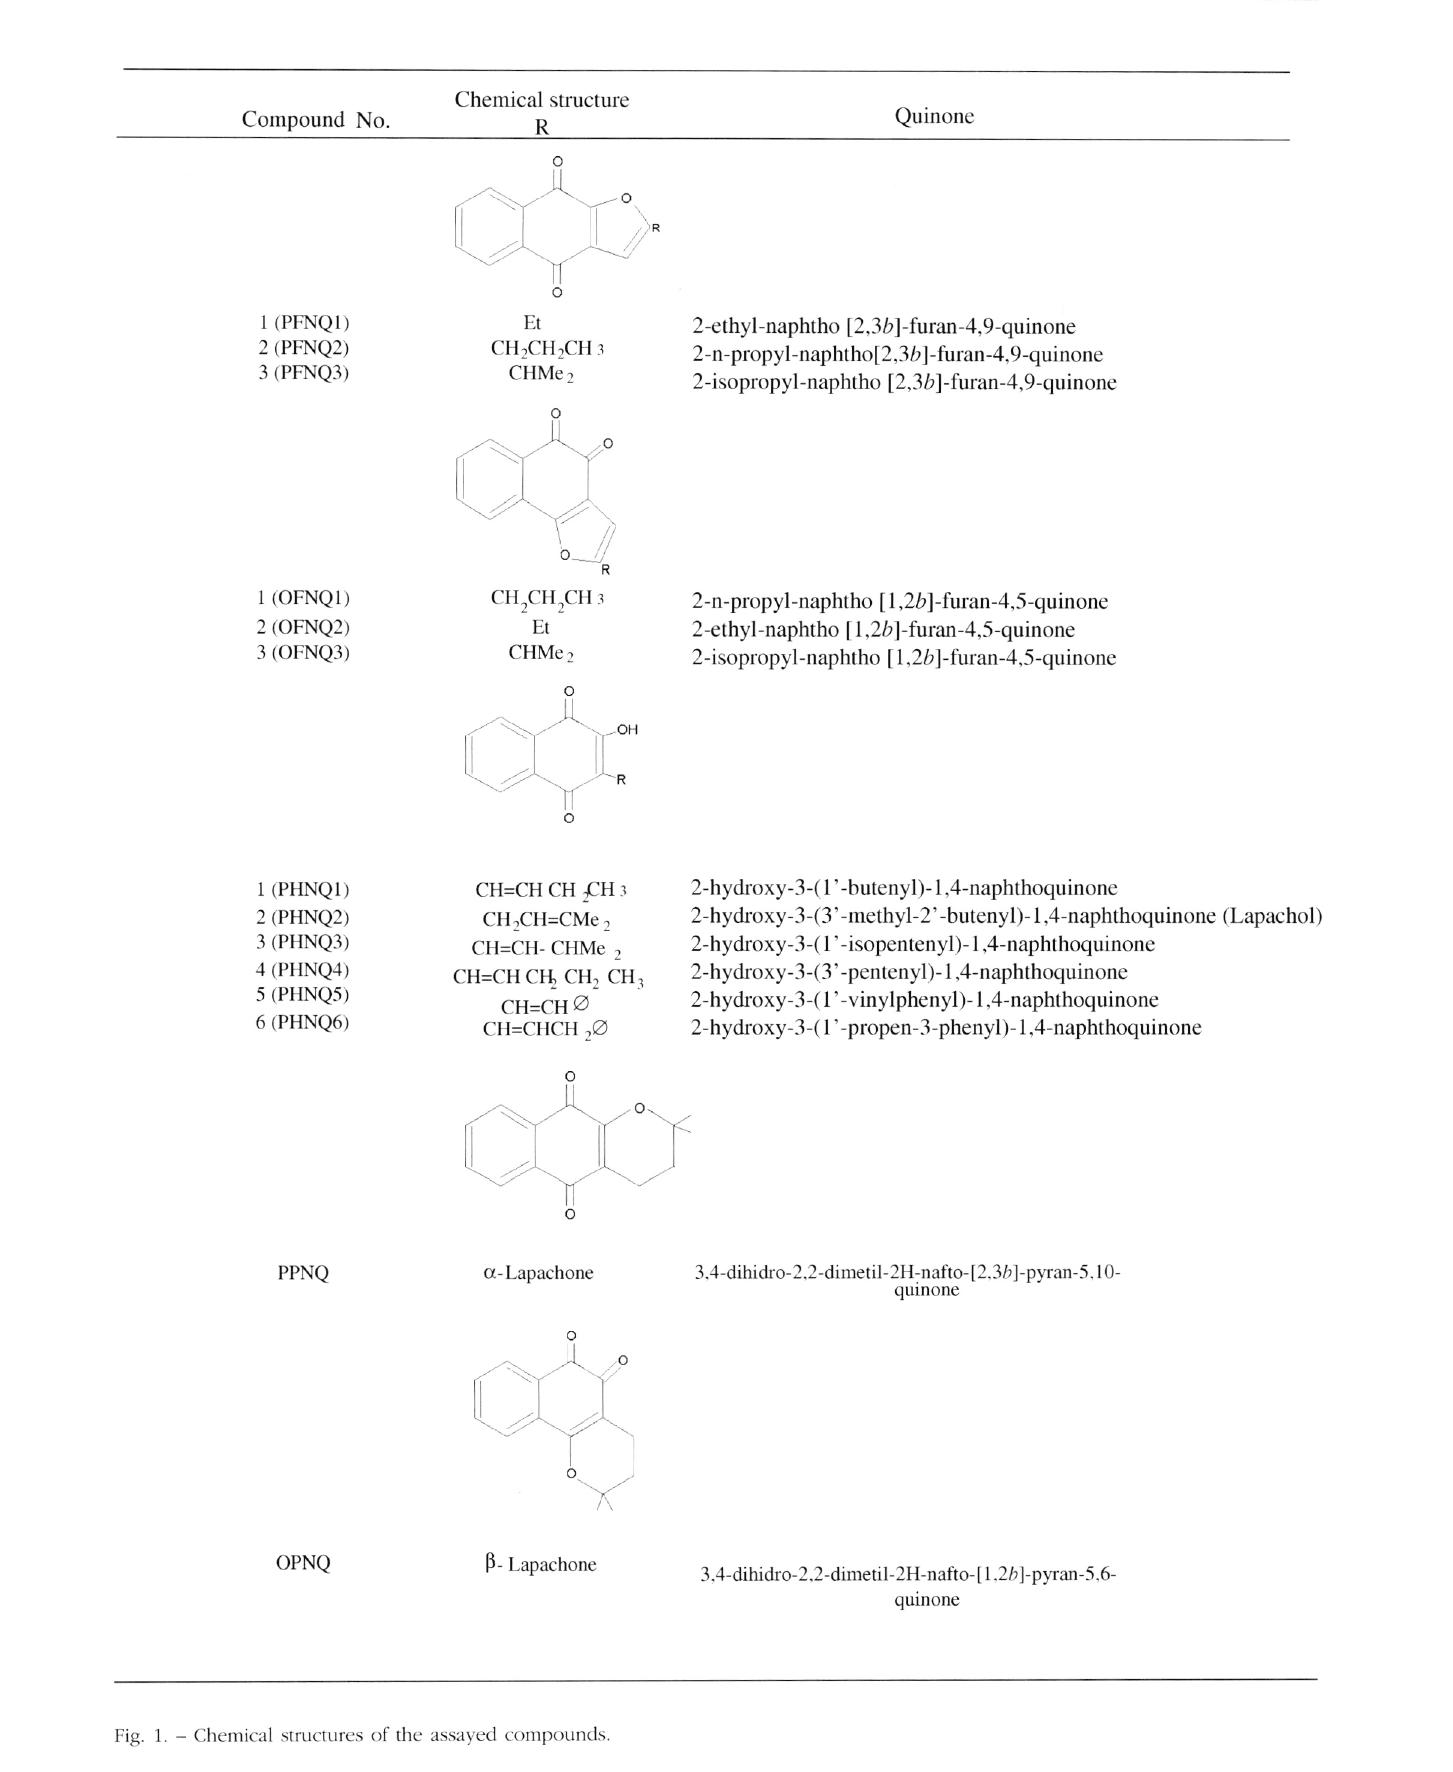
Fig. 1. - Chemical structures of the assayed